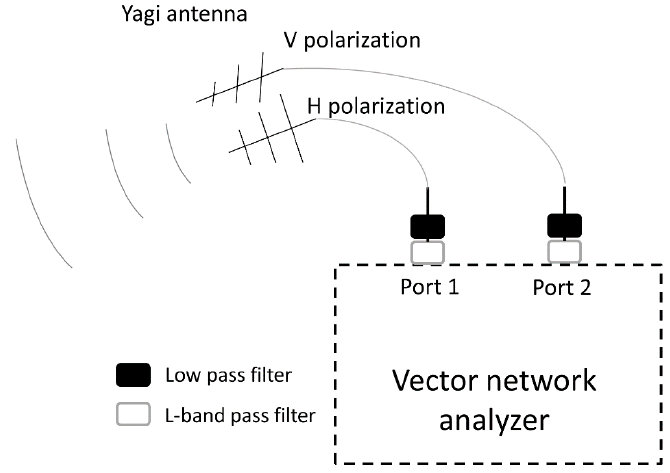
Figure 1. Ground-based radar system.